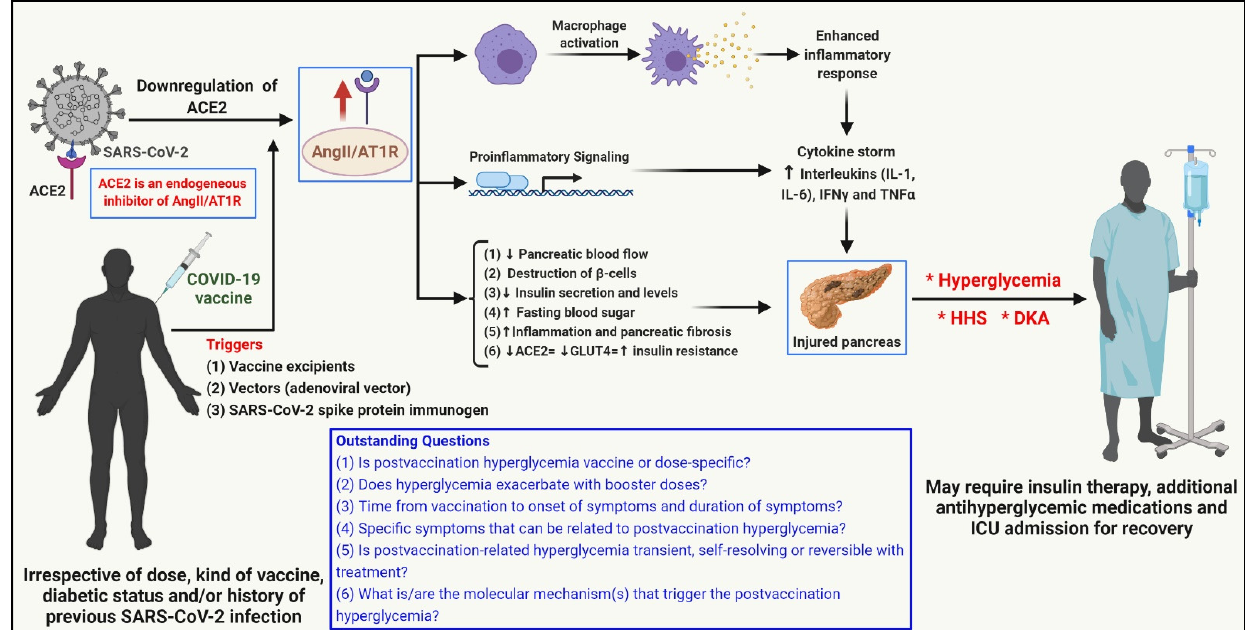
Figure 1. Possible mechanism of COVID-19 vaccination-associated pancreatic injury and hyper- glycemia/hyperglycemic complications (figure adapted and modified from [7]). The angiotensin- converting enzyme 2 (ACE2) receptor, the key binding site for the SARS-CoV-2 virus, is a key regulator of the renin–angiotensin–aldosterone system (RAAS) and an endogenous inhibitor of the angiotensin II/angiotensin II type 1 receptor (AngII/AT1R) axis. SARS-CoV-2 binding to the pancreatic cells that express the ACE2 receptor and subsequent ACE2 downregulation diminish the inhibitory effect of ACE2 on the AngII/AT1R axis, which in turn leads to macrophage activation, upregulation of proinflammatory pathways, and hypercytokinemia (cytokine storm), culminating in pancreatic injury. It may be possible that vaccine excipients, vectors (adenoviral vectors), and the COVID-19 vaccine SARS-CoV-2 spike protein immunogen trigger similar mechanisms that cause pancreatic injury and subsequent hyperglycemia and hyperglycemic complications, such as hyperglycemic hyper- osmolar syndrome (HHS) and diabetic ketoacidosis (DKA). Studies are warranted to address the outstanding questions in this area. Created with BioRender.com. * indicates potential postvaccination hyperglycemic